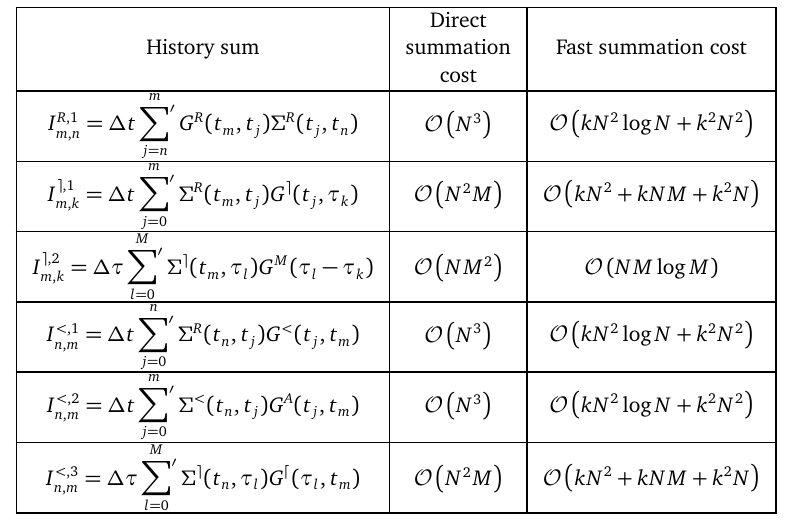
Table 1: History sums and the total cost of computing them for all index values by direct summation and by our method. The sums are trapezoidal rule discretizations of the underlying integrals. k is a bound on the ranks of all blocks in the compressed representations. The total cost of building these representations by on the fly TSVD (cid:0) (cid:0) (cid:1)(cid:1) k 2 N 2 + N M updates is O